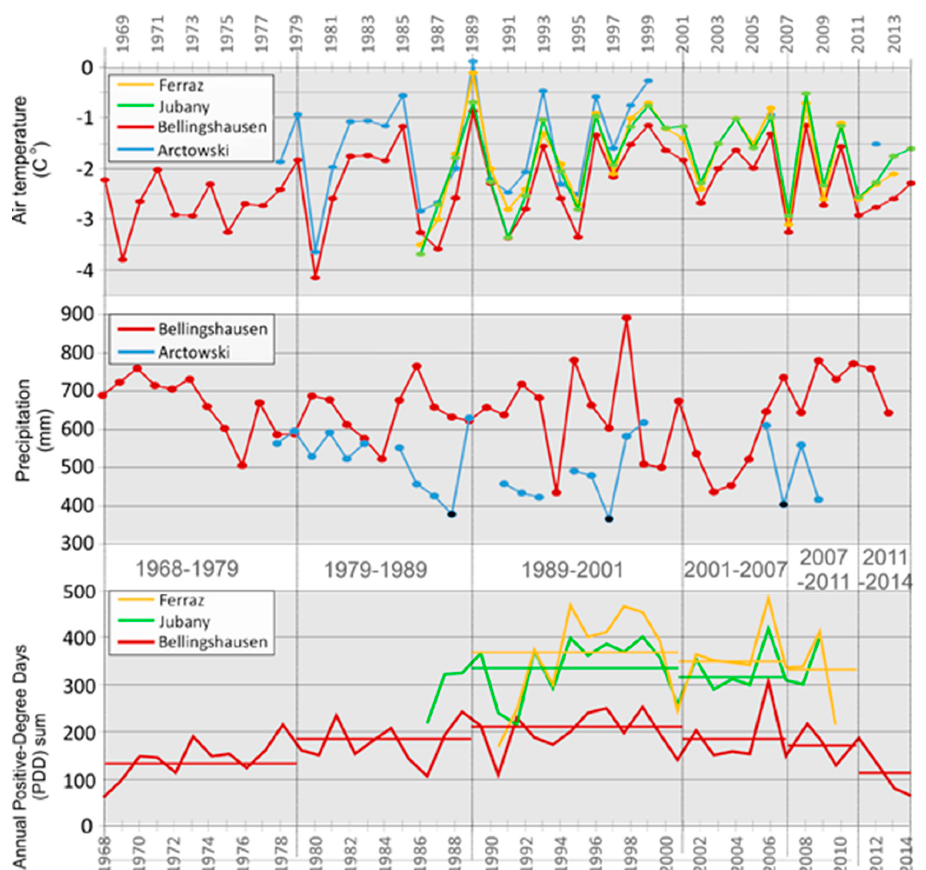
Figure 2. The average air temperature, precipitation, and averages for the periods analysed in this paper. The trends are from the Arctowski (A, 1977–1999), Bellingshausen (B, 1968–2014), Jubany (J, 1986–2014), and Ferraz (F, 1986–2013) stations. All plots from the Arctowski Station are based on